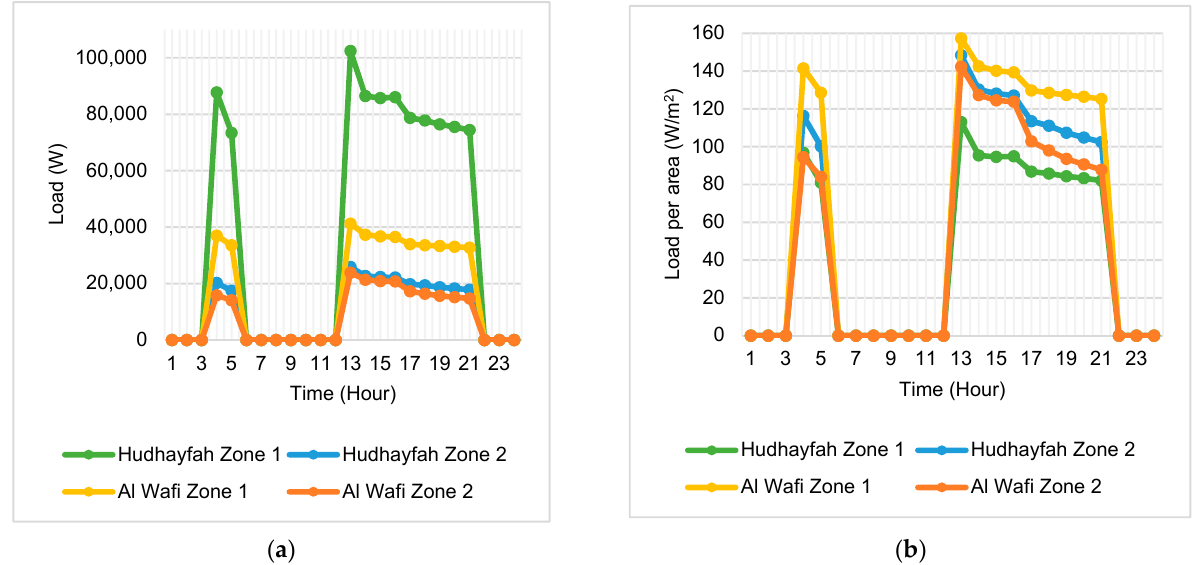
Figure 19. ( a ) Comparison between Hudhayfah and Al Wafi mosque’s total cooling loads across Zones 1 and 2 for both mosques during day 179 (Summer); ( b ) comparison between Hudhayfah and Al Wafi mosque’s cooling loads per area across Zones 1 and 2 for both mosques during day 179 (Summer).